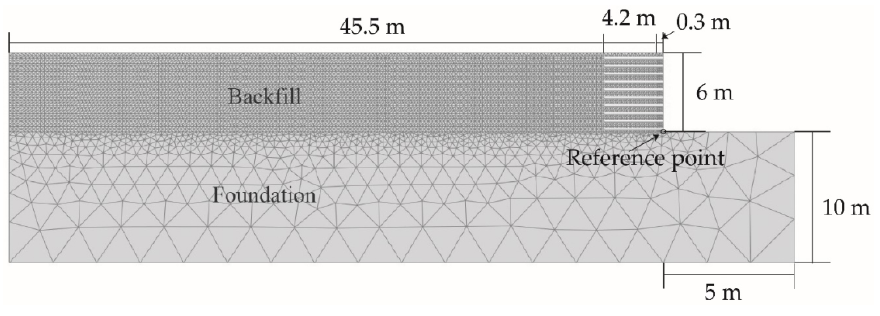
Figure 9. Mesh and dimension of the numerical model.